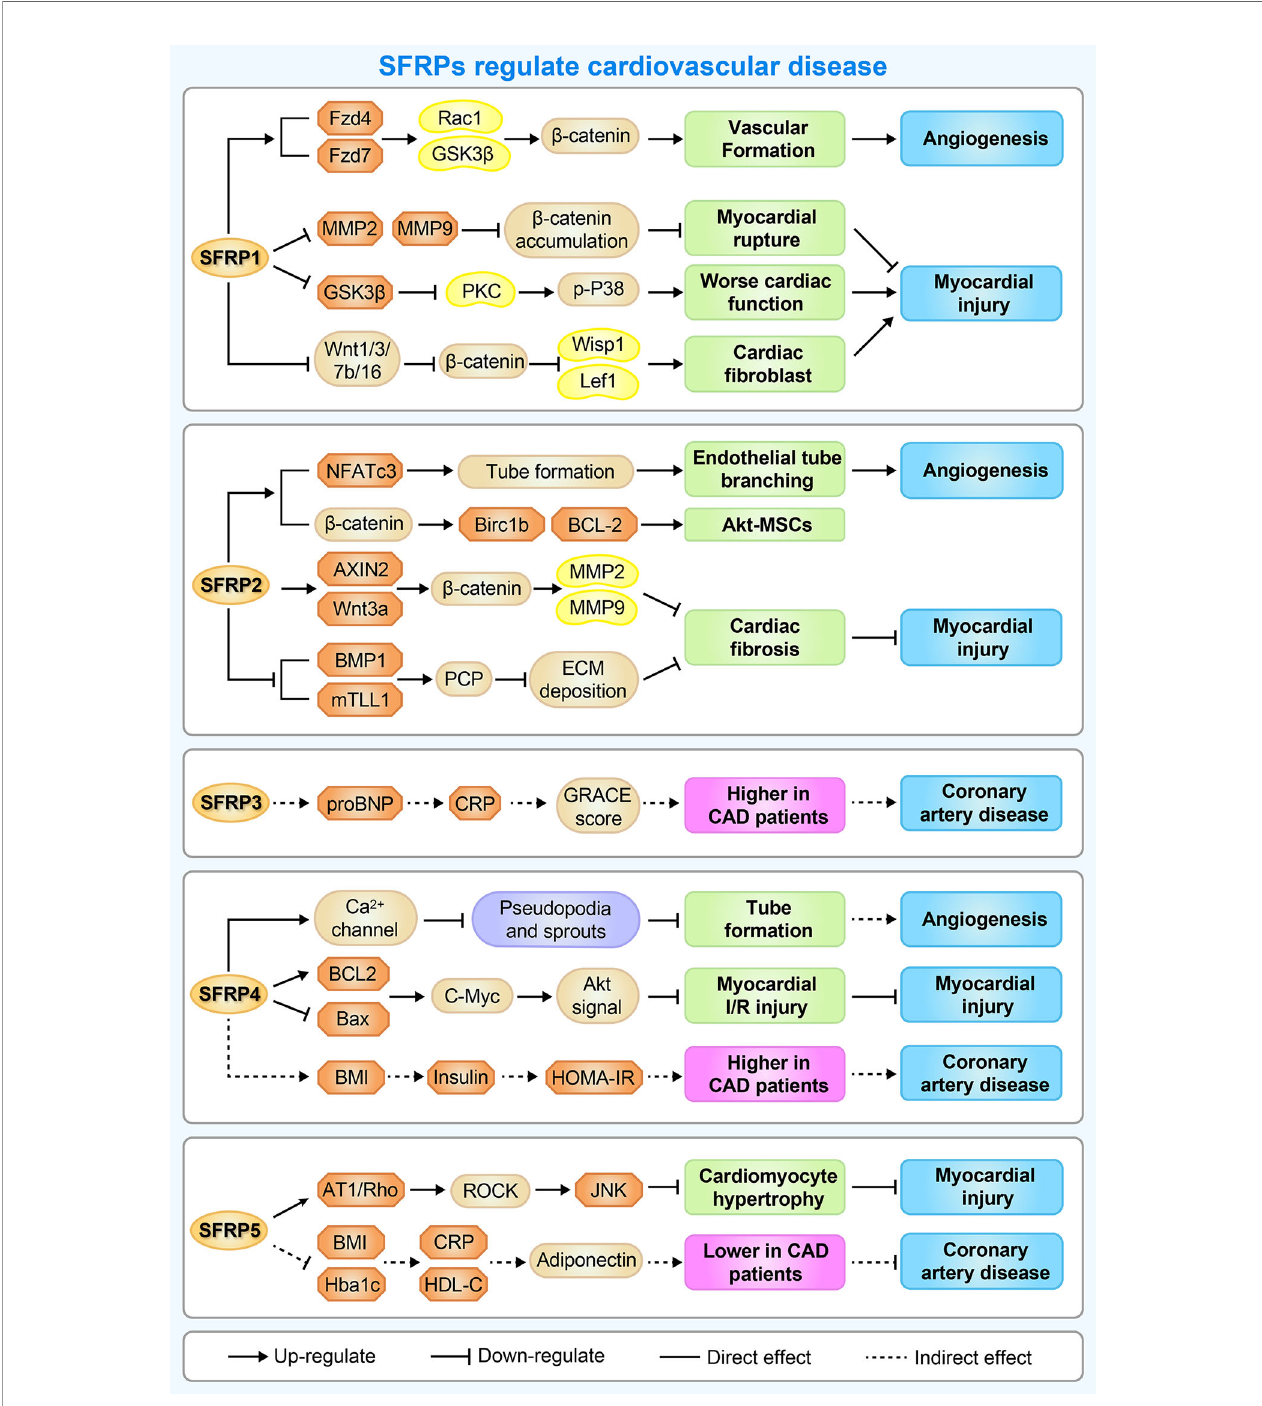
FIGURE 4 | A brief overview of the molecular mechanisms by which SFRPs regulate cardiovascular disease. The fi gure shows the potential mechanisms by which how SFRPs modulate cardiovascular diseases including angiogenesis, myocardial injury and coronary artery disease. AT1, arginine ADP-ribosyltransferase 1; AXIN2, axin protein 2; BAX, BCL2 associated X, apoptosis regulator; BCL-2, B cell leukemia/lymphoma 2; Birc1b, NLR family, apoptosis inhibitory protein 2; BMP1, bone morphogenetic protein 1; C-Myc, MYC proto-oncogene, bHLH transcription factor; CRP, C-reactive protein; ECM deposition, Subclass B3 metallo beta lactamase gene family; Fzd4/7, frizzled class receptor 4/7; HDL-C, High-density lipoprotein; HOMA-IR, Homeostasis model assessment-IR; JNK, c-Jun NH2-terminal kinase; Lef1, lymphoid enhancer binding factor 1; MMP2, matrix metalloproteinase 2; NFATc3, nuclear factor of activated T cells, cytoplasmic, calcineurin dependent 3; PKC, protein kinase C; Rac1, Rac family small GTPase 1; ROCK, Rho-associated coiled-coil containing protein kinase; WISP1, WNT1 inducible signaling pathway protein 1; Wnt1, wingless-type MMTV integration site family, member 1.